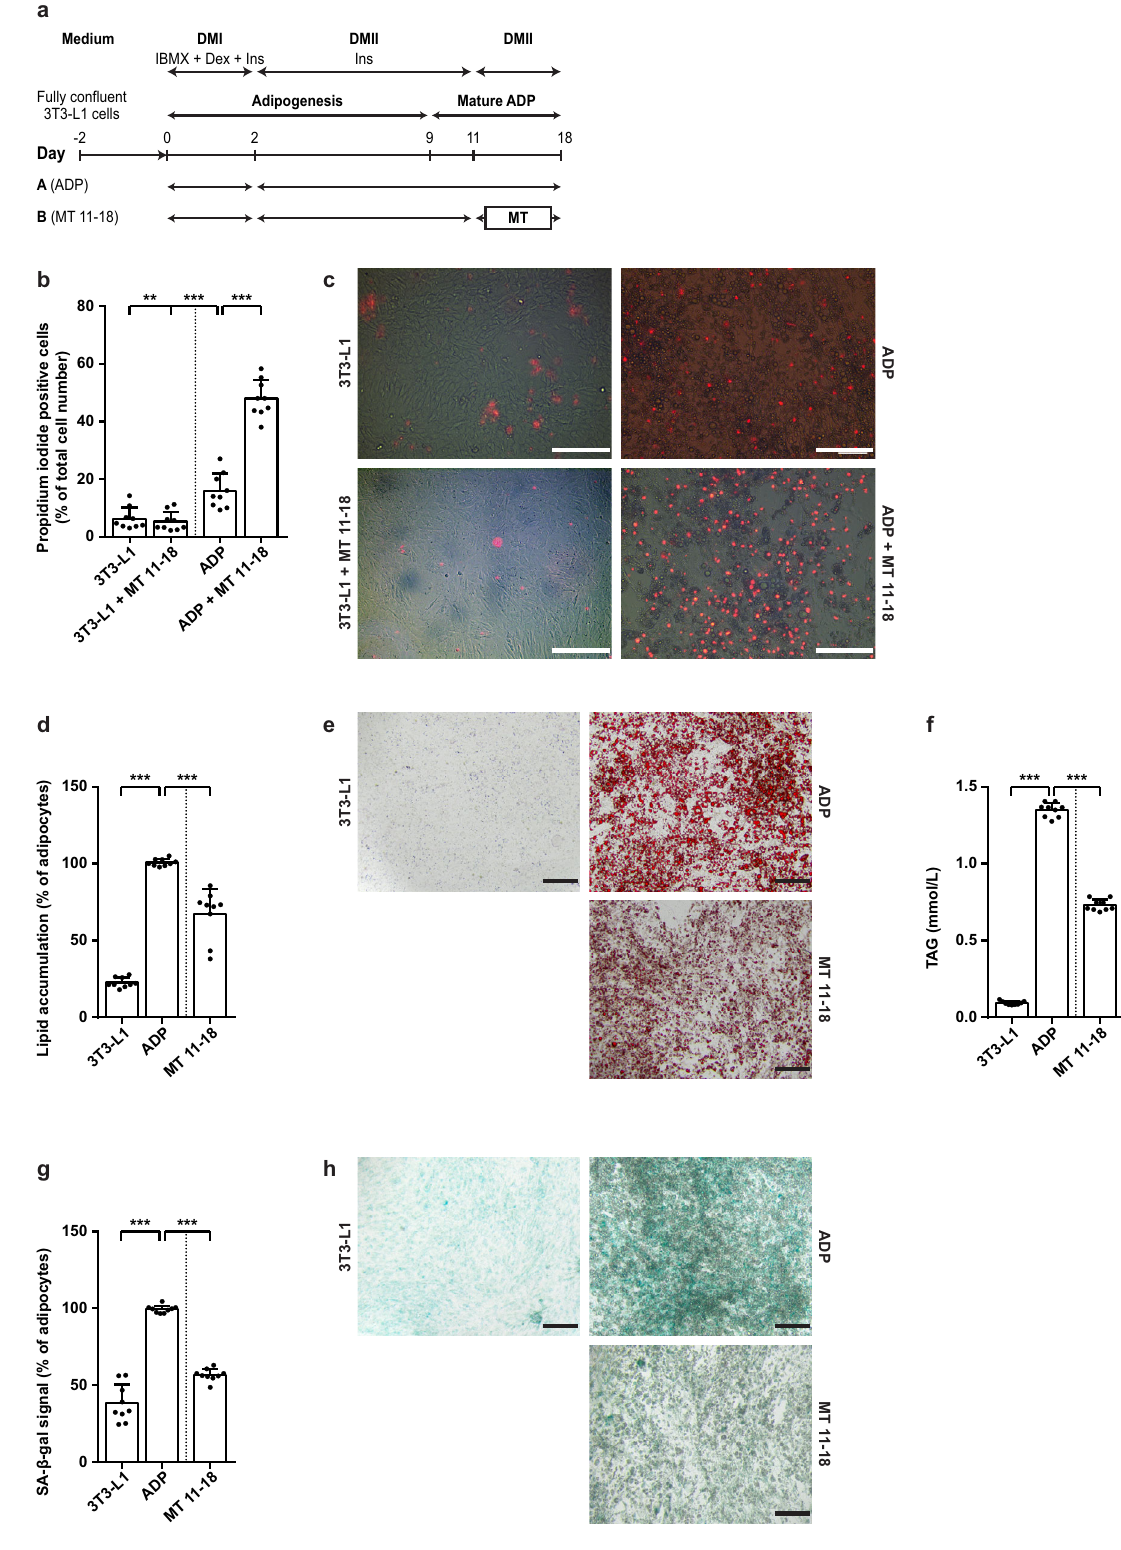
Methods Ethical statement . This research complies with all relevant ethical regulations. Experiments were performed in agreement with the Animal Protection Law of the Czech Republic and were approved by the Ethics Committee of the Institute for Clinical and Experimental Medicine, Prague (permit number 41/2018) and the Ethics Committee of the Institute of Molecular Genetics, Prague (permit number 51/2018). The human study was approved by the Human Ethics Review Board of